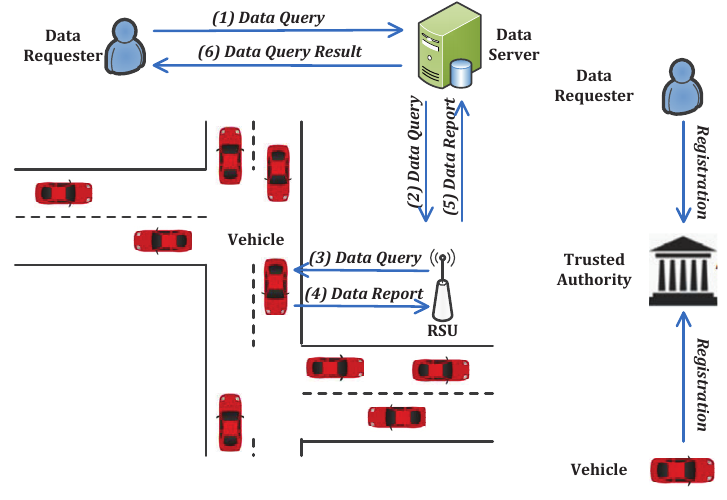
Figure 1. Data query